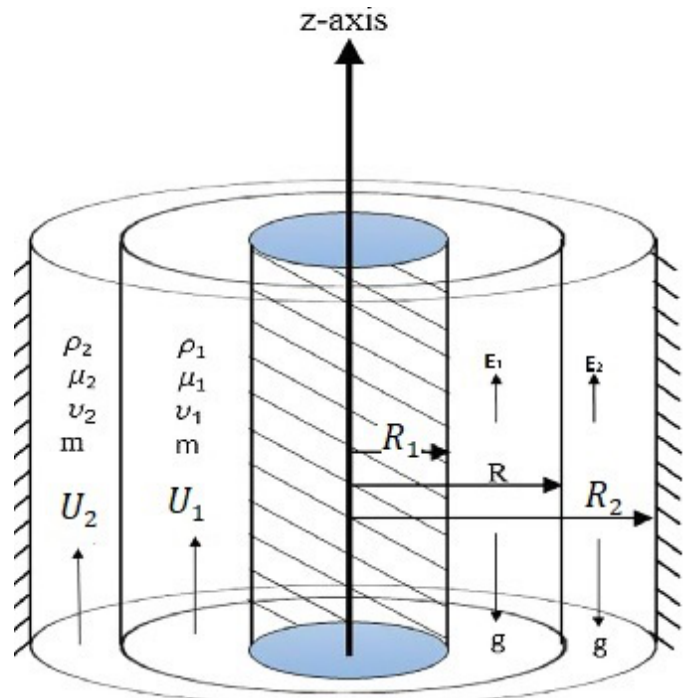
Figure 1. A sketch of the physical